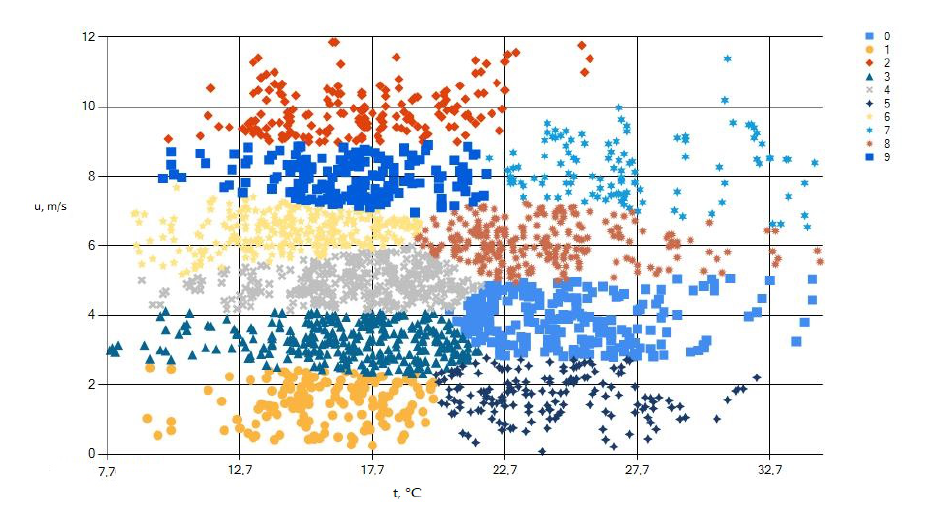
Figure 4. The results of APS cluster analysis in spring.